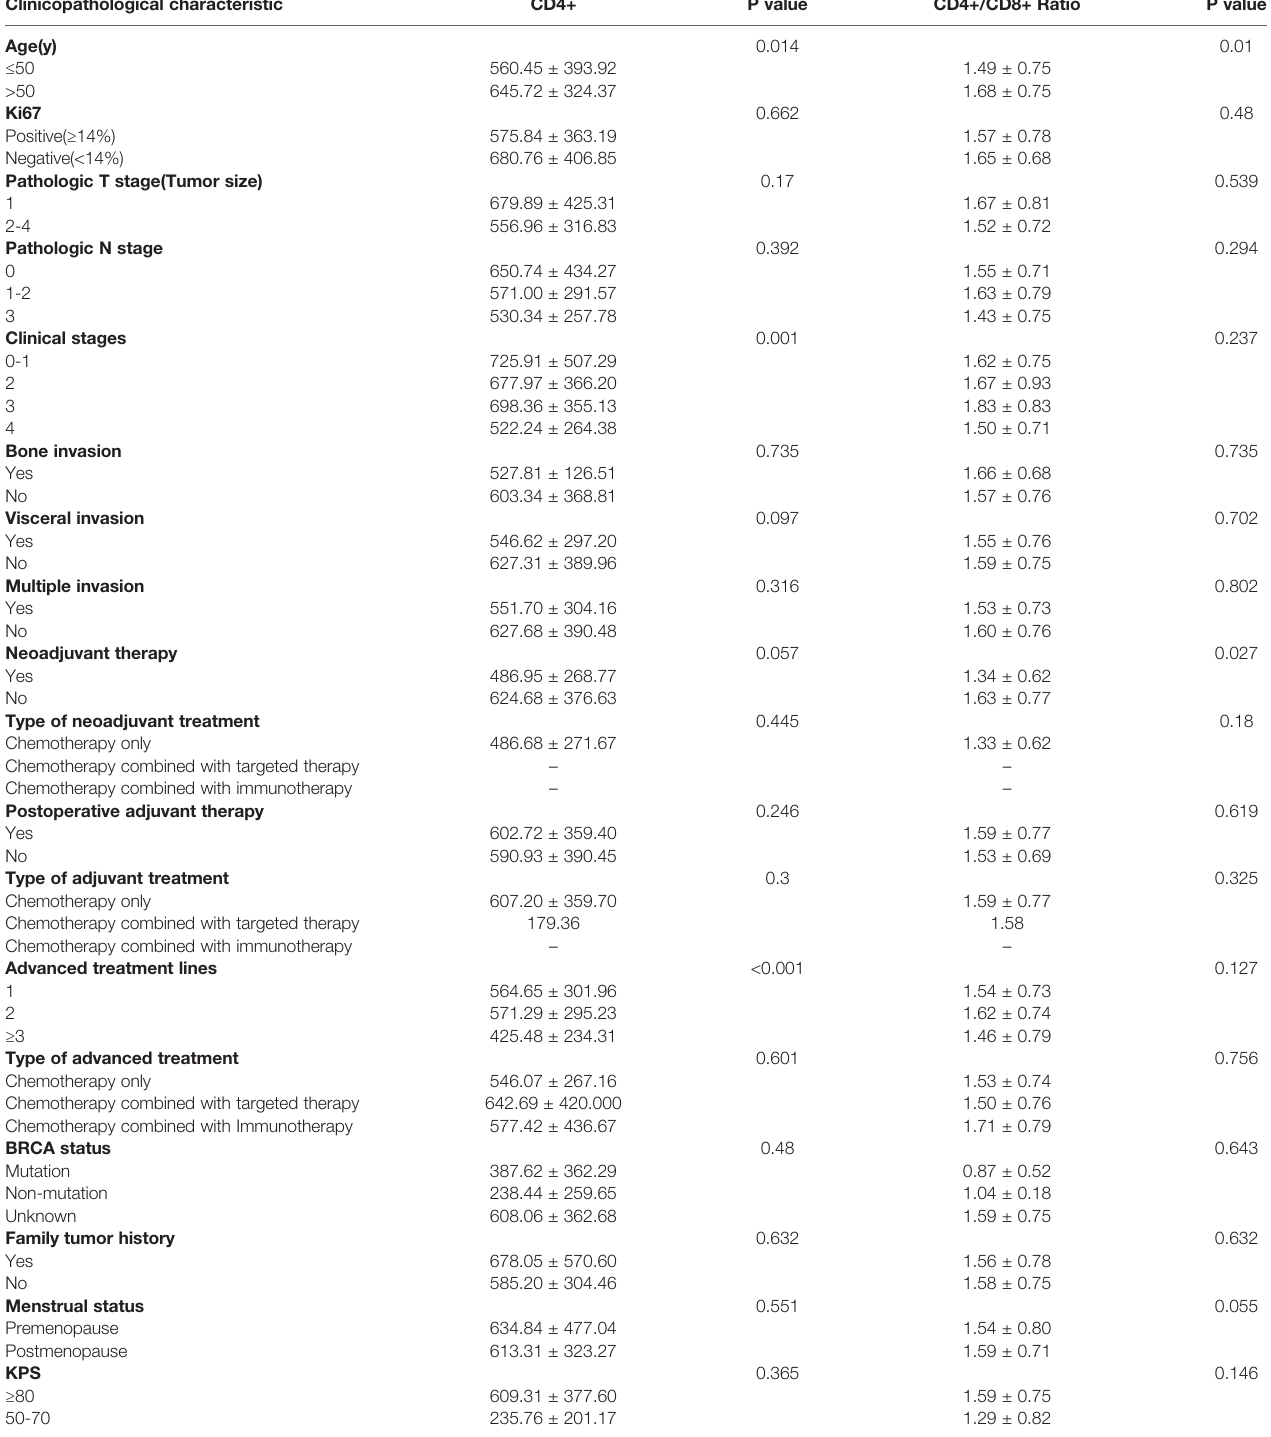
TABLE 5 | Spearman ’ s Rho and Mann-Whitney test for comparison of clinicopathological parameters according to peripheral CD4+ and CD4+/CD8+ in